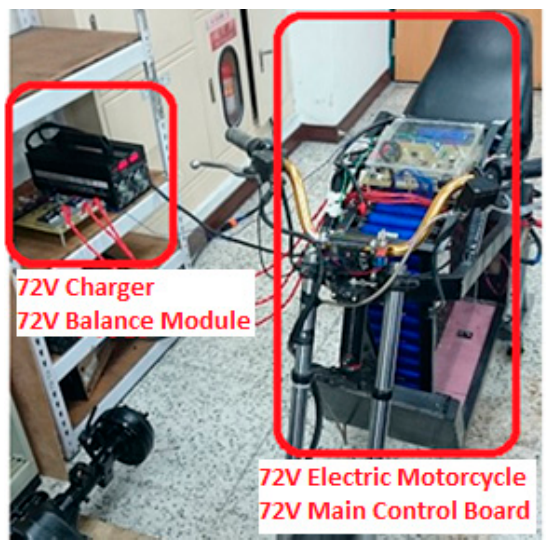
Figure 8. Charging platform with independent balance module.